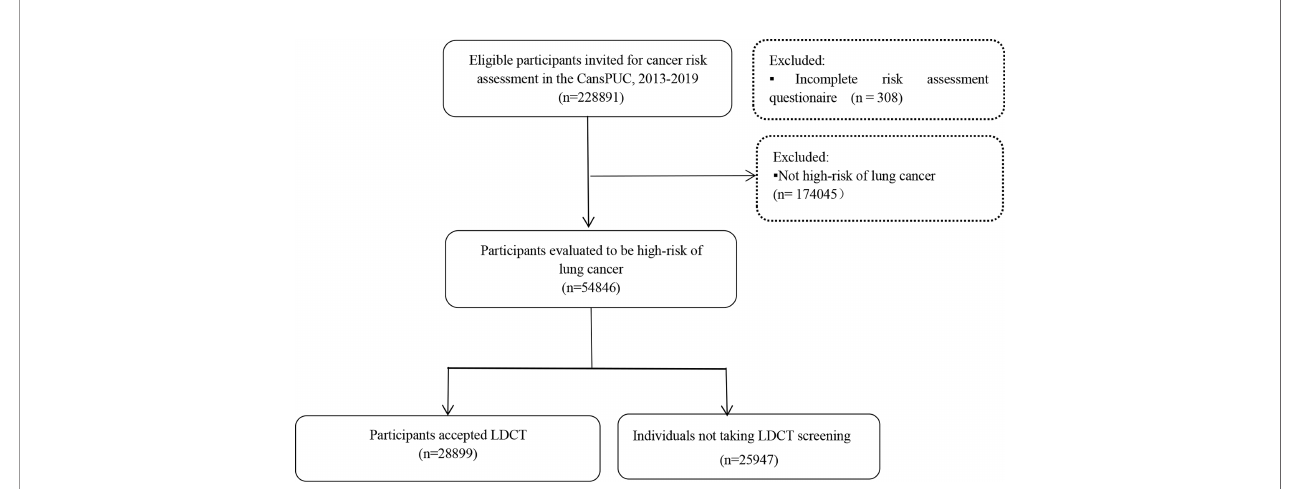
FIGURE 1 | The fl ow chart of lung cancer screening in Hebei province,